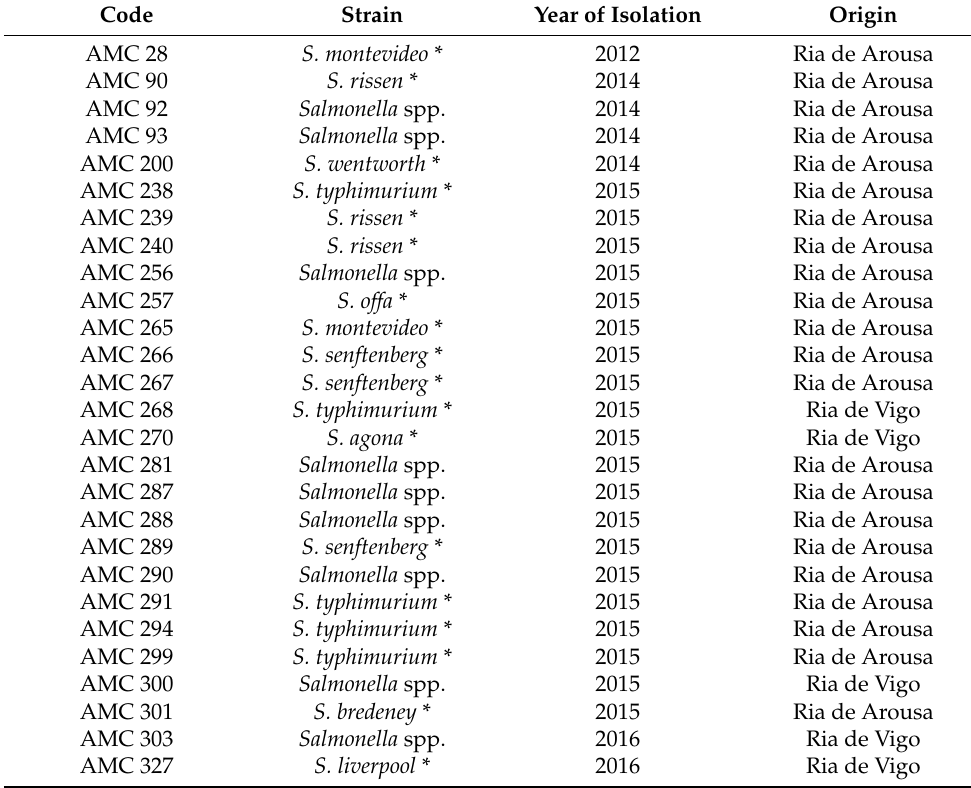
Table 3. Salmonella strains isolated in the present